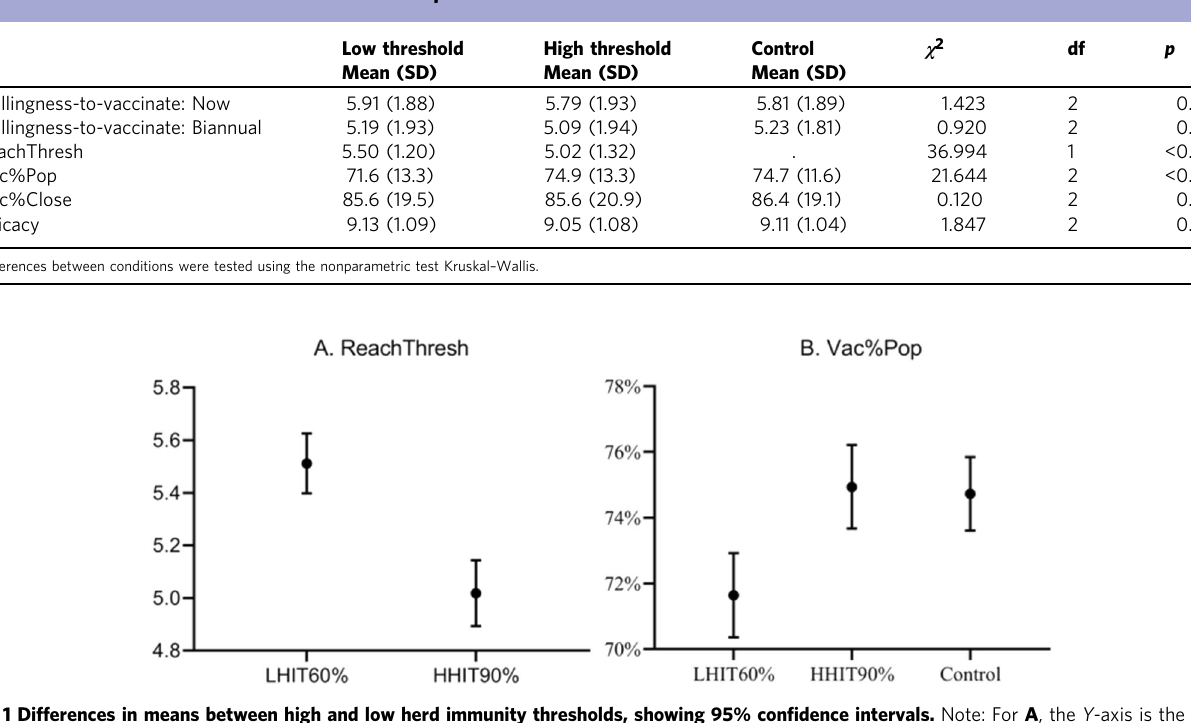
Table 1 Mean values and differences across experimental conditions.